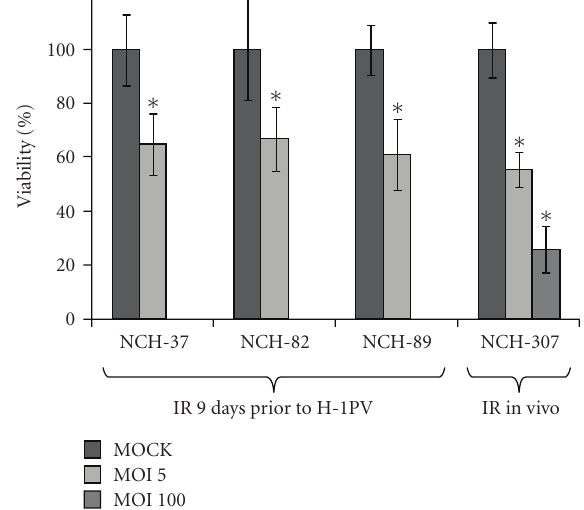
Figure 1: E ff ects of late parvovirus H-1 (H-1PV) infection on human high-grade glioma cells surviving ionizing radiation (IR). Short- term cultures of human gliosarcoma NCH-37, human glioblastoma NCH-82, and human glioblastoma NCH-89 were seeded at 30,000 cells/well, irradiated with 10Gy and infected with H-1PV at an MOI of 5PFU/cell 9 days post-IR (MOI 5) and compared to mock- infected cells surviving IR (MOCK). The short-term culture of in vivo irradiated recurrent glioblastoma NCH-307 was seeded at 30,000 cells/well and infected with H-1PV at low (MOI = 5PFU/cell: MOI 5) or high (MOI = 100PFU/cell: MOI 100) virus doses and compared to mock-infected cells. All experiments were performed in three independent assays. Viability (%) was assessed as the number of living treated cells over the number of living untreated cells three days post (mock-) infection. Error bars represent the respective standard error. ( ∗ ) indicates significant di ff erences ( P < . 001) between the number of living infected and the corresponding number of living MOCK-infected